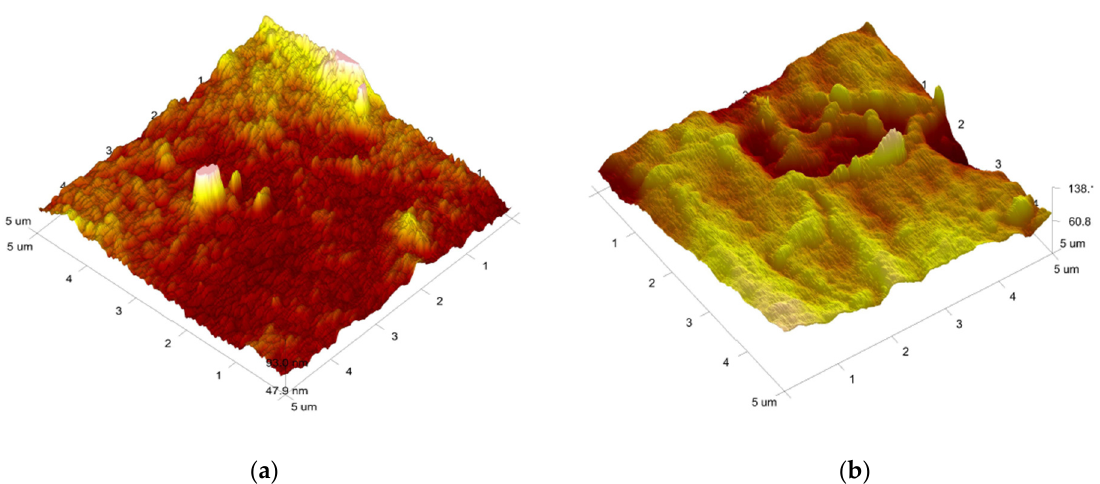
Figure 3. AFM images of the surface morphology of CNC films plasticized with 15% glycerol; ( a ) neat, ( b ) CA-30%. Roughness parameter: neat: R q = 5.3 nm; CA-30%: R q = 2.8 nm.